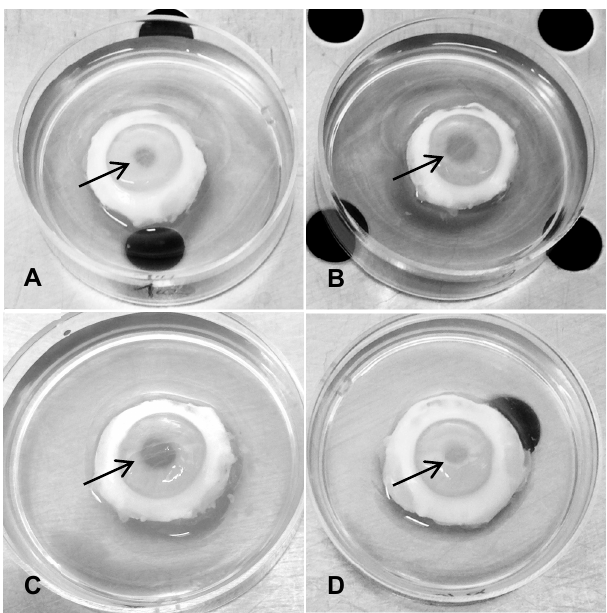
Figure 2. Clinical signs in treated corneas. The sclero-corneal rings were randomly divided into groups of three rings each treated as follows: ( A ), pI (pre-immune) rabbit serum as control; ( B ), gB1s recombinant protein; ( C ), gB1s recombinant protein preincubated with the anti-pK rabbit polyclonal specific antibody; ( D ), gB1s recombinant protein preincubated with the anti-gB1s rabbit polyclonal specific antibody. Arrows are indicating the pupil. For each group n = 3.